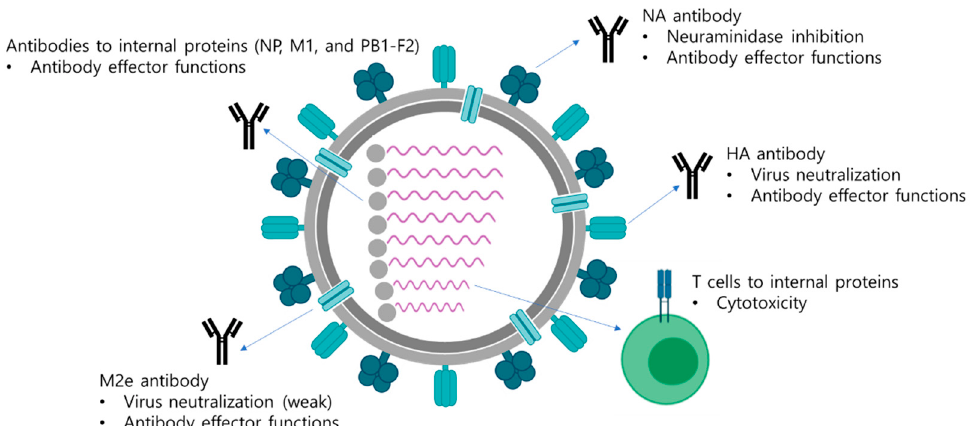
Figure 1. Multifaceted immune responses induced by a LAIV. A LAIV mimics a natural infection and induces multifaceted immune responses including antibody responses and T cell responses. Antibodies directed to surface antigens, HA, NA, and M2e neutralize the virus and also mediate antibody effector functions, such as ADCC, ADCP, and CDC, to eliminate virus-infected cells. The internal viral proteins are also target antigens for generation of antibodies with effector functions. Whether the effector functions of antibodies directed to the internal proteins have protective roles has not been clearly elucidated yet. In addition, cytotoxic T cells are directed to the internal viral proteins, which mediate the elimination of virus-infected cells via direct contact of cytokine production.